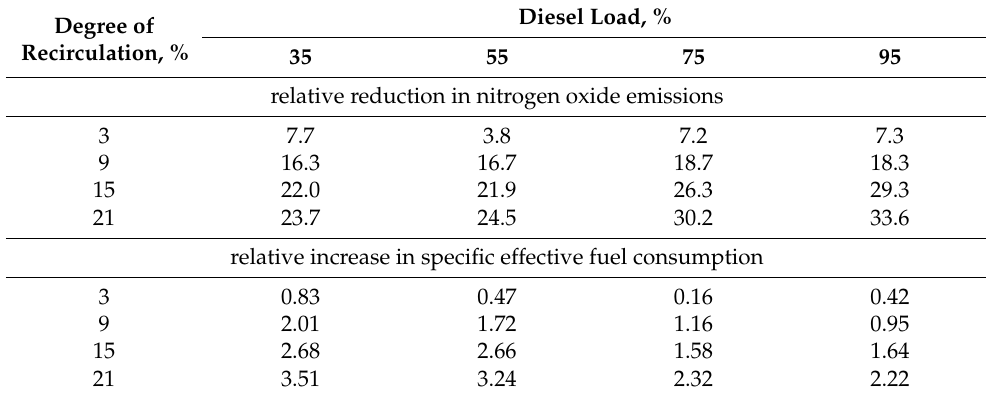
Table 3. Environmental efficiency and fuel efficiency marine diesel 16V32 STX-MAN when using the EGR system.